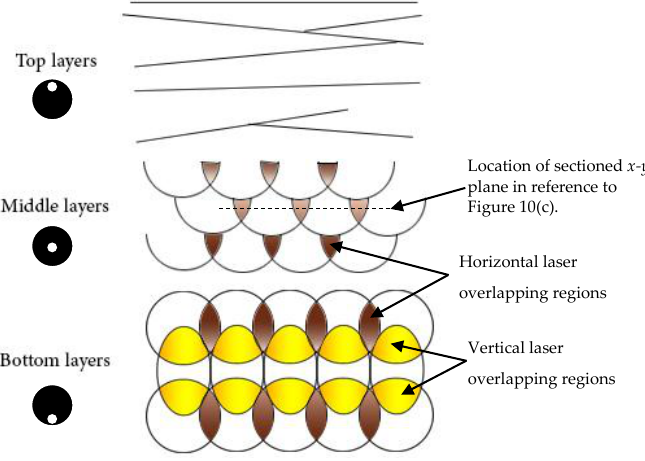
Figure 11. Illustration of vertical and horizontal laser overlapping and their influence on the melt pool morphology.